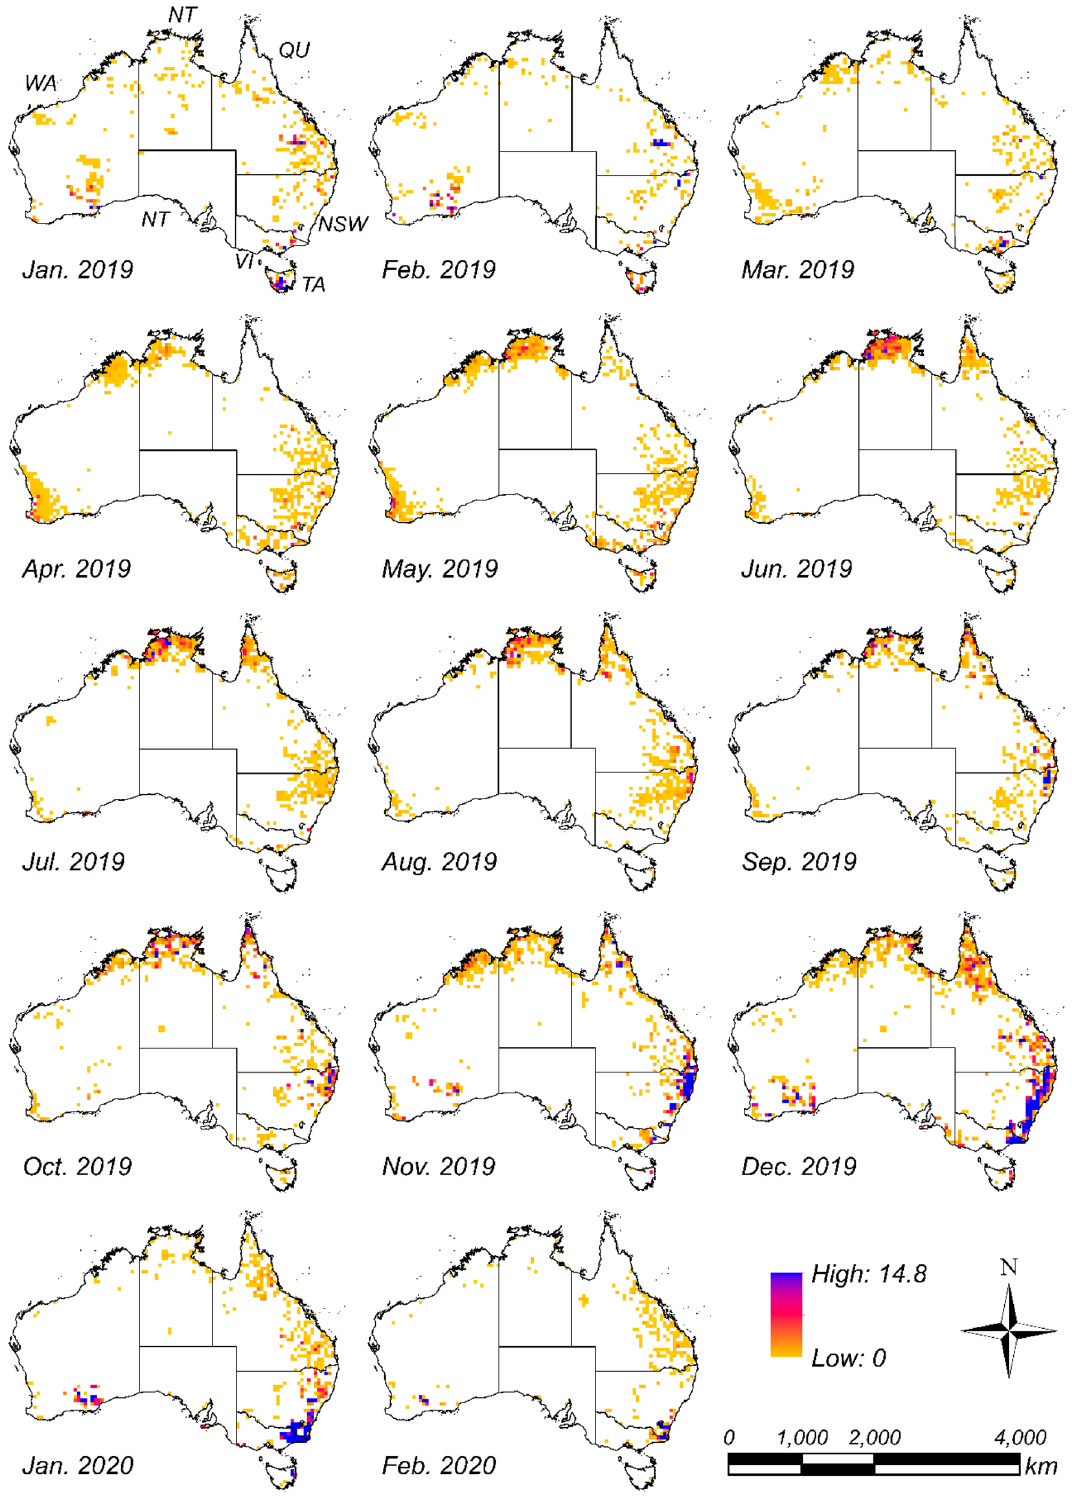
Figure 1. Estimated monthly CO 2 emissions (Tg CO 2 grid −1 month −1 ) time series between January 2019 and February 2020. CO 2 emissions are the total amount in each 50 km × 50 km grid. Abbreviations in the top-left figure for January 2019 indicate the state names, namely, New South Wales (NSW), Queensland (QU), South Australia (SA), Tasmania (TA), Victoria (VI), Western Australia (WA), and Northern Territory (NT). Maps were created with ArcGIS version 10.5 (https:// www. arcgis.